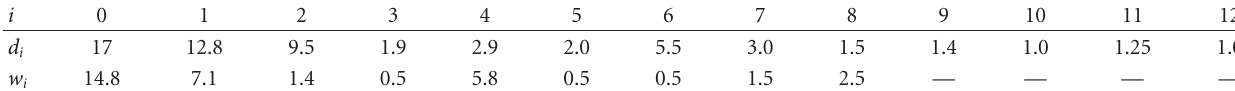
Table 2: d i and w i values, measured in mm, for the antenna with PIN diode.